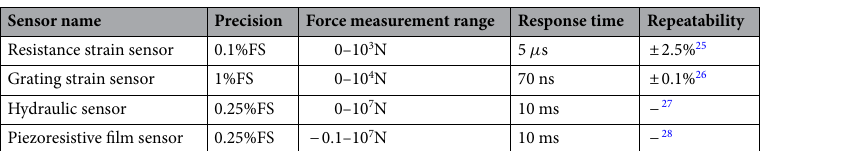
Table 1. Performance indicators for different types of sensors.